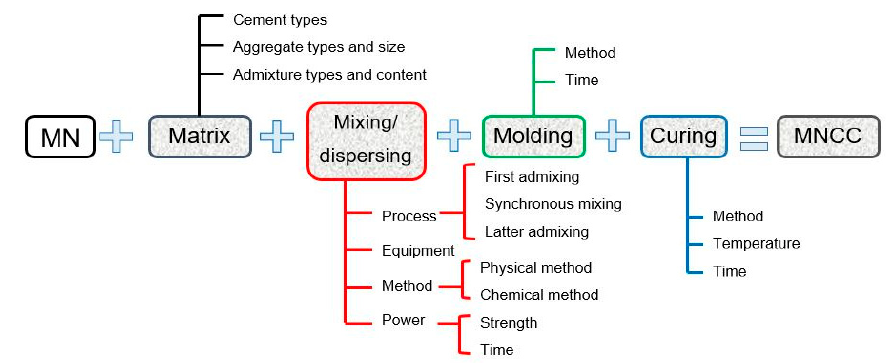
Figure 6. Scheme of the preparation process of magnetite nanoparticles cement composites (MNCC), based on Li et al. (Reprinted with permission from [42]. Copyright 2018 Elsevier).